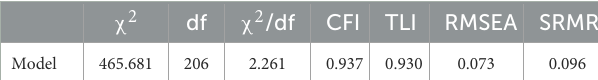
TABLE 3 Model fit indices of the proposed model ( n =